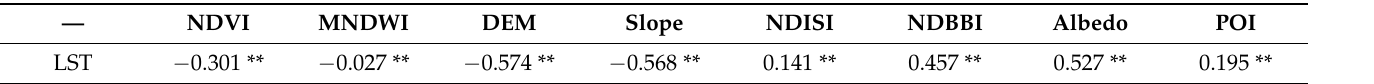
Table 7. Correlation coefficients between factors and LST.